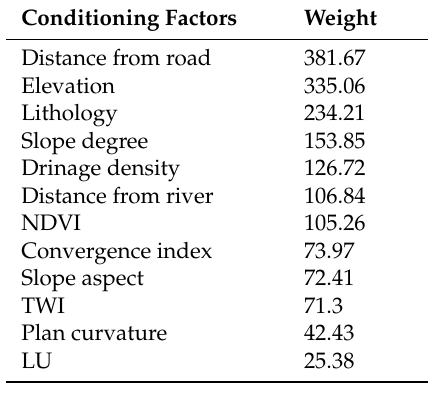
Table 5. Relative influence of effective conditioning factors in the RF model.